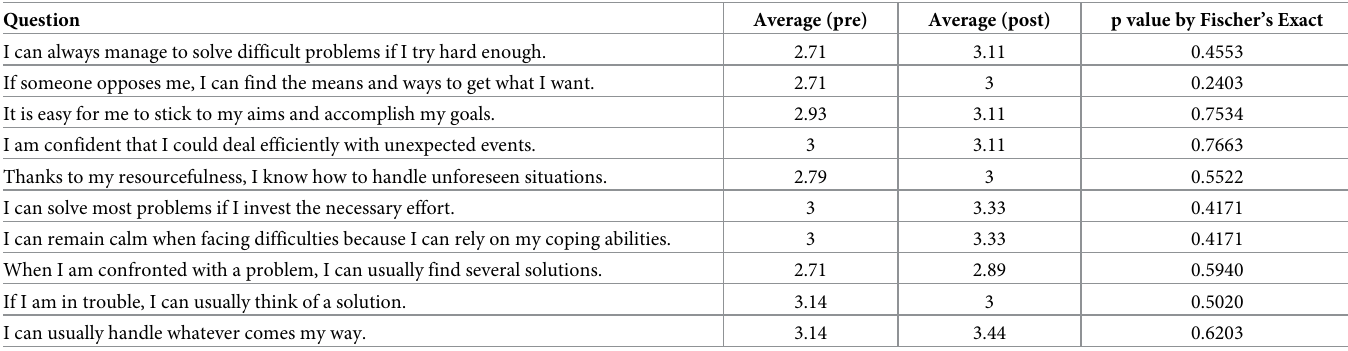
Table 3. Similar self efficacy scores pre and post QI